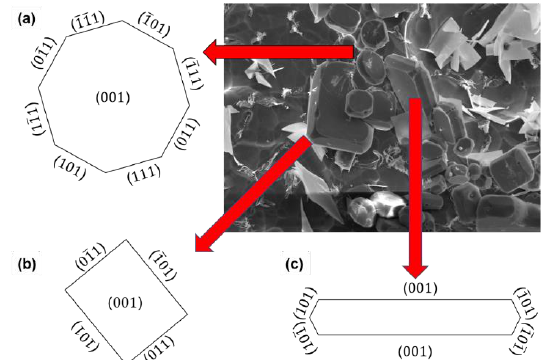
Figure 8. Microstructure of the primary Al 3 Zr crystal in the cross section: ( a ) octagonal form ( b ) and rectangular form; and the longitudinal section: ( c ) tabular form.